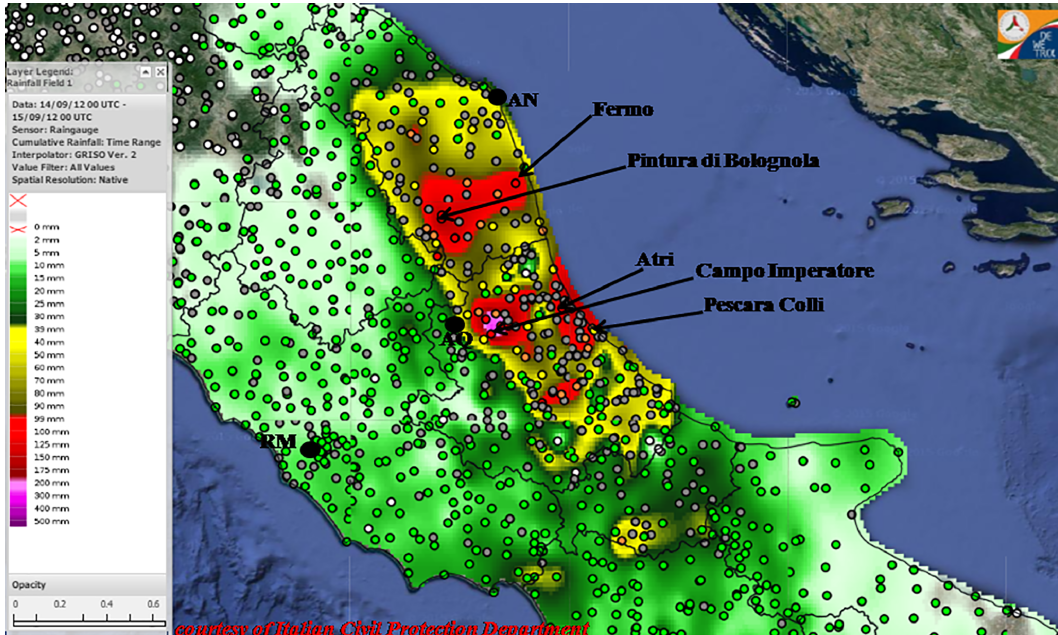
Figure 10. Interpolated map of 24h accumulated rainfall from 00:00UTC on 14 September 2012 over central Italy taken from the DEWE- TRA system from rain gauge measurements. Black contours are the administrative boundaries of the regions, while the colored circles represent the warning pluviometer thresholds (from Maiello et al., 2017; courtesy of the Italian Department of Civil